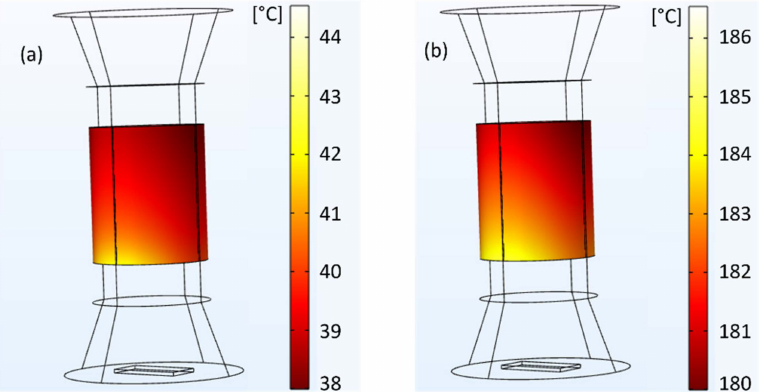
Figure 15. Slice distribution of the temperature in the zeolite’s bed after 5 ( a ) and 25 ( b )